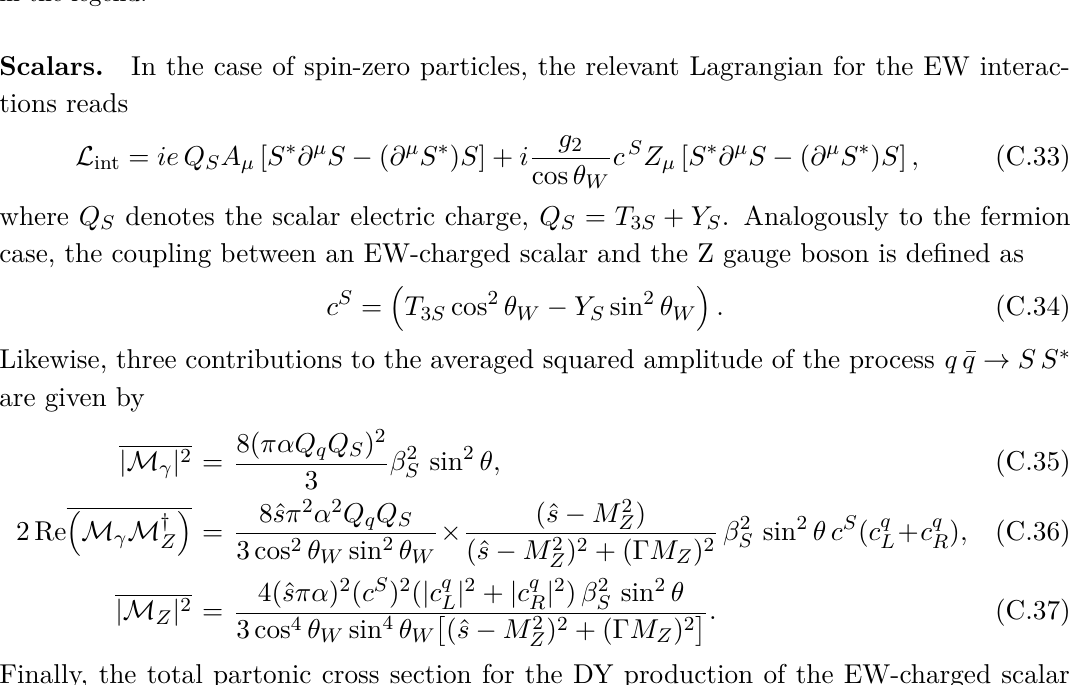
Figure 11 . Total hadronic cross section in pp collisions at of fermions (left panel) and scalars (right panel) in different SU(2) red), doublet (dashed blue) and singlet (solid green). The corresponding hypercharges are indicated in the